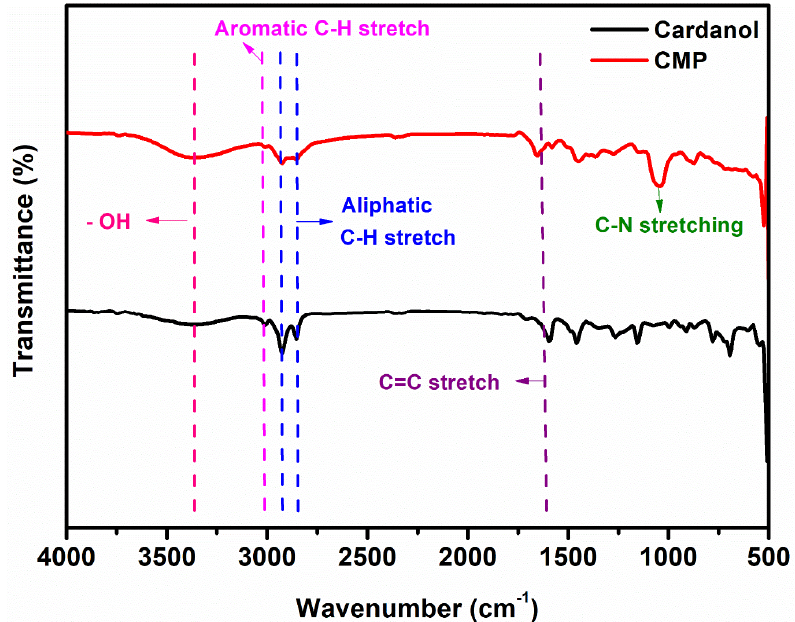
Figure 2. FT-IR spectra of cardanol and cardanol Mannich polyol.